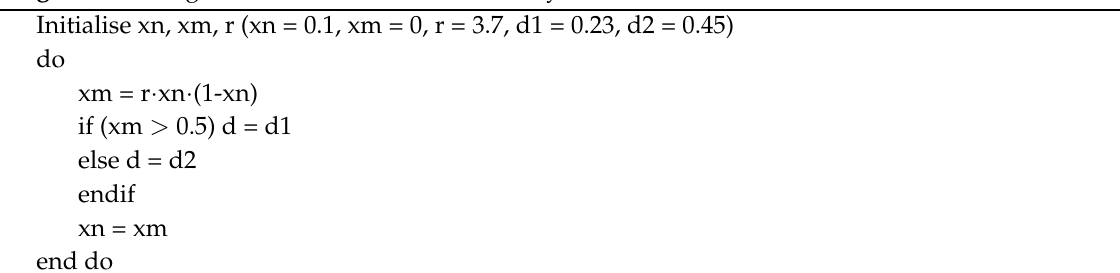
Algorithm 1: Algorithm of the random time delay on the